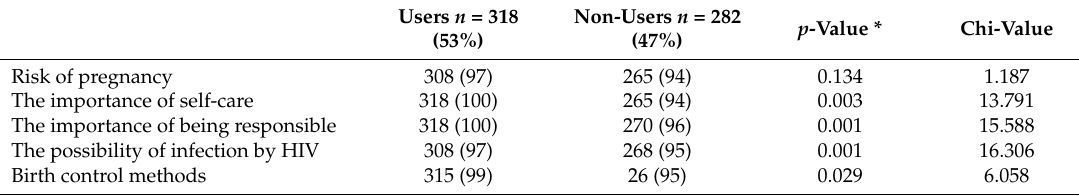
Table 2. Percentage distribution of the main topics that the adolescent were informed about at the onset of menarche (%), according to the use of birth control methods before pregnancy.